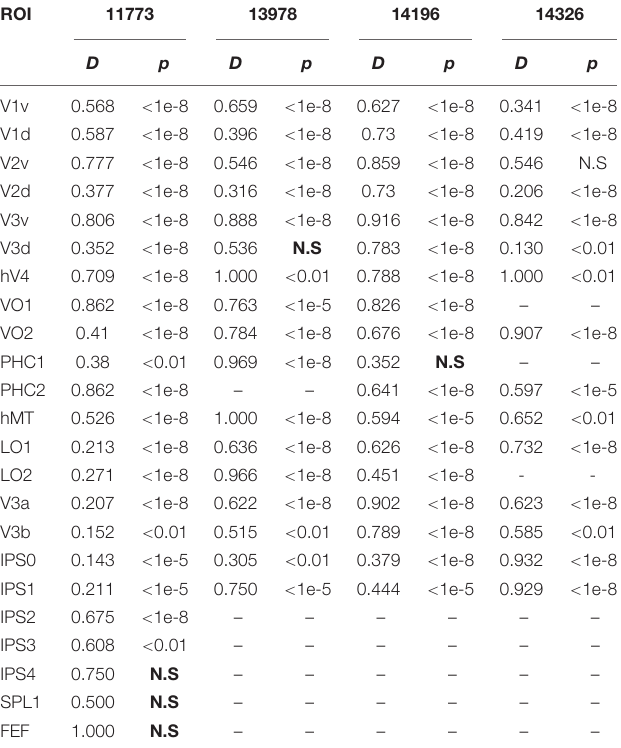
TABLE 3 | Differences in population receptive field coverage in lesioned and healthy